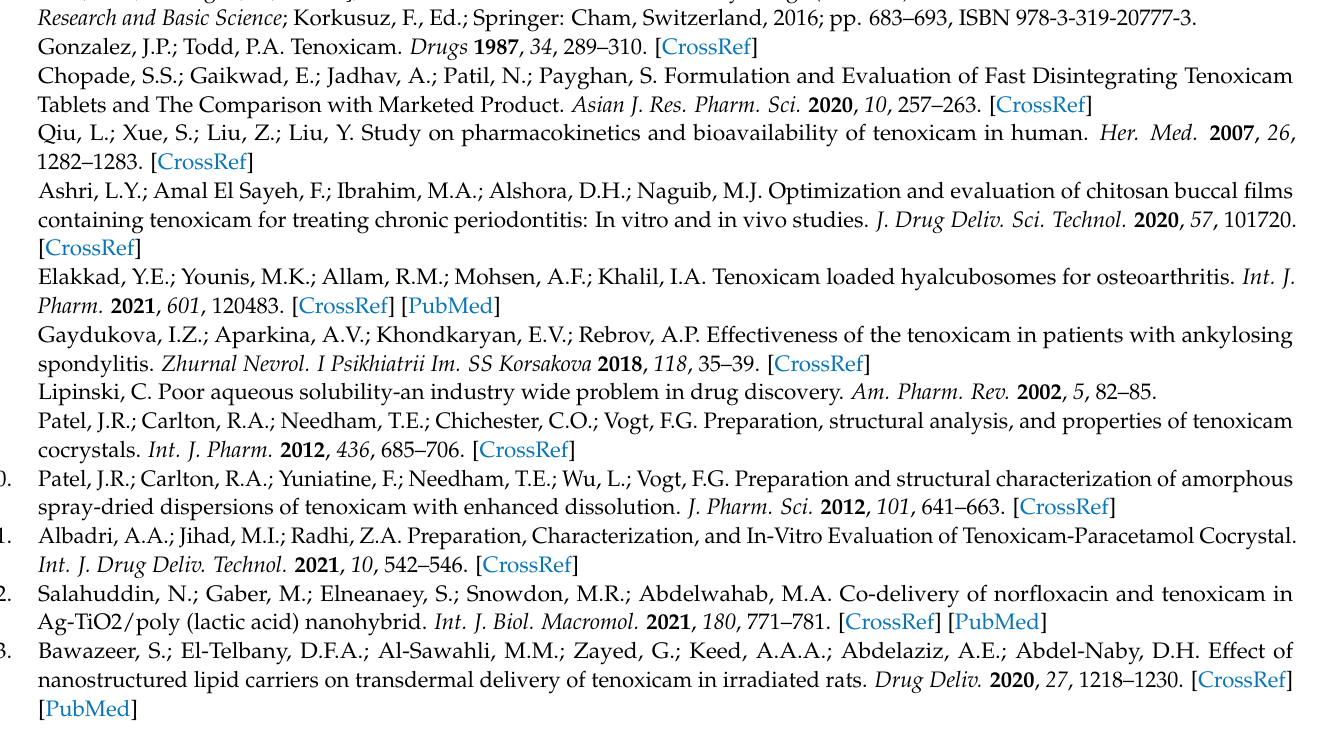
Figure S1: DSC and TG profiles of TNX, CCFs, and the corresponding